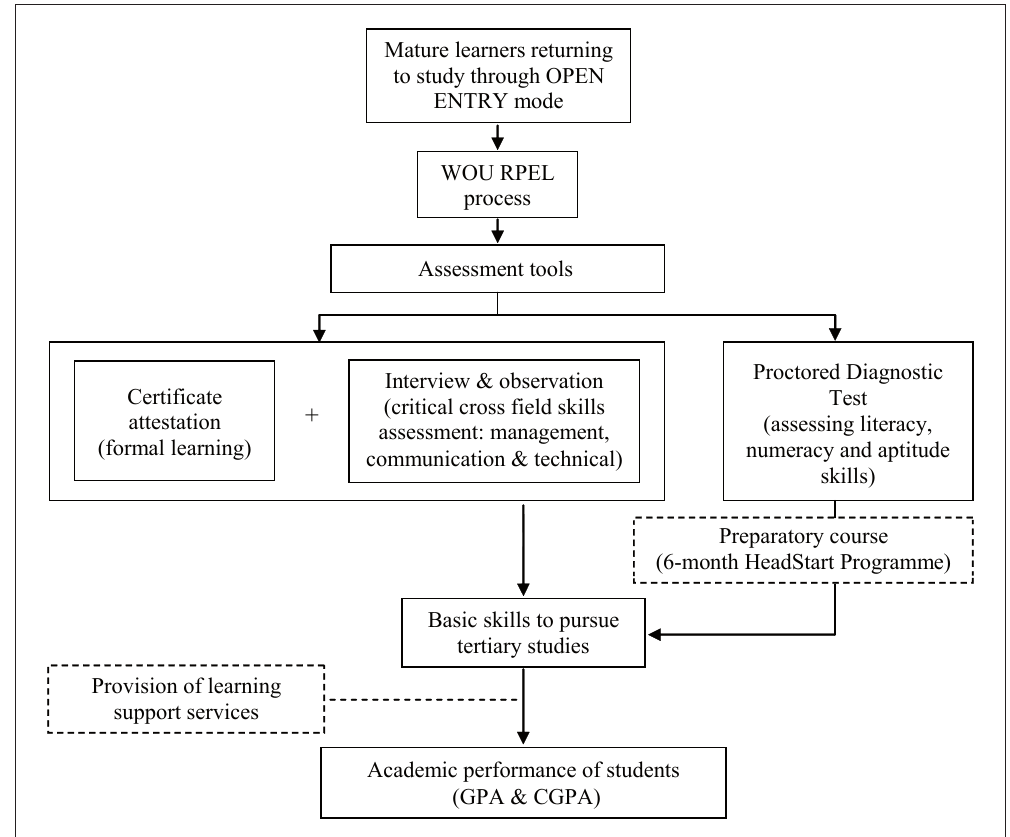
Figure 2 Conceptual framework of the case